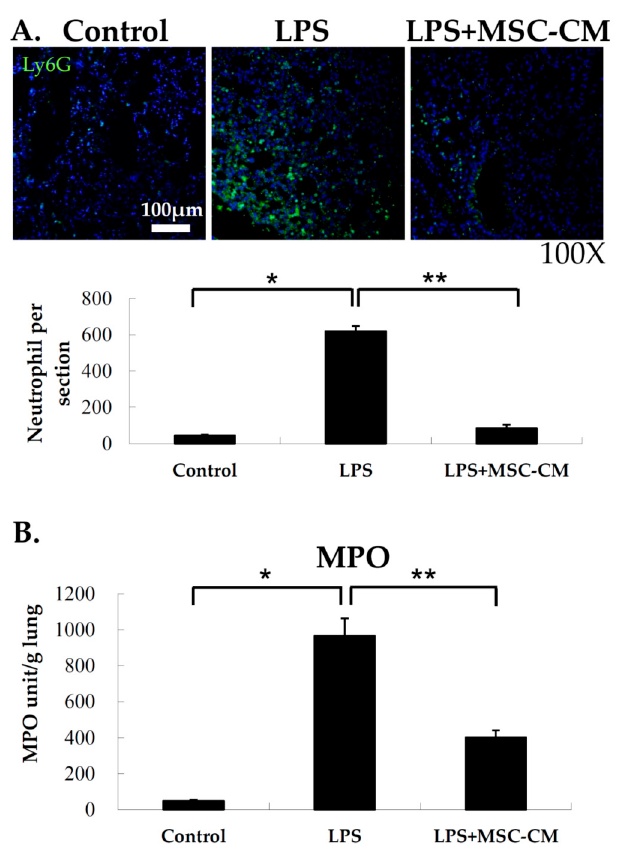
Figure 3. MSC-CM reduced neutrophil accumulation in the lungs of LPS-induced ALI mice. ( A ) Neutrophil accumulation was examined with immunofluorescent staining of lung tissues for Ly6G, a neutrophil marker. Neutrophil accumulation in alveoli significantly increased after LPS exposure (LPS) and was significantly reduced following administration of the MSC-CM (LPS + MSC-CM). Green: Ly6G (lymphocyte antigen 6G); Blue: 4’,6-diamidino-2-phenylindole (DAPI). Magnification = 100 × . Scale bar = 100 µ m. The number of neutrophils per section for lung tissue samples stained for Ly6G are presented as the mean ± SD. ( B ) Myeloperoxidase (MPO) activity was detected in whole lung tissue lysates and the data indicate that there was significant neutrophil accumulation. LPS mice (LPS) had a higher level of MPO in the lung compared to the control mice, whereas the mice that received LPS + MSC-CM had decreased levels of MPO compared to LPS mice. Data are presented as the mean ± SD. * p < 0.05, compared to the controls; ** p < 0.05, compared to the LPS group; n = 6 per group.